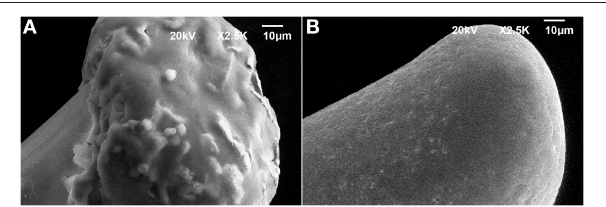
FIGURE 12 | Representative SEM images of (A) PEDOT-PSS-CNT coated microsphere (without pHEMA) and (B) pHEMA encapsulated PEDOT-PSS-CNT coated microsphere after 28 days of permanence in rat